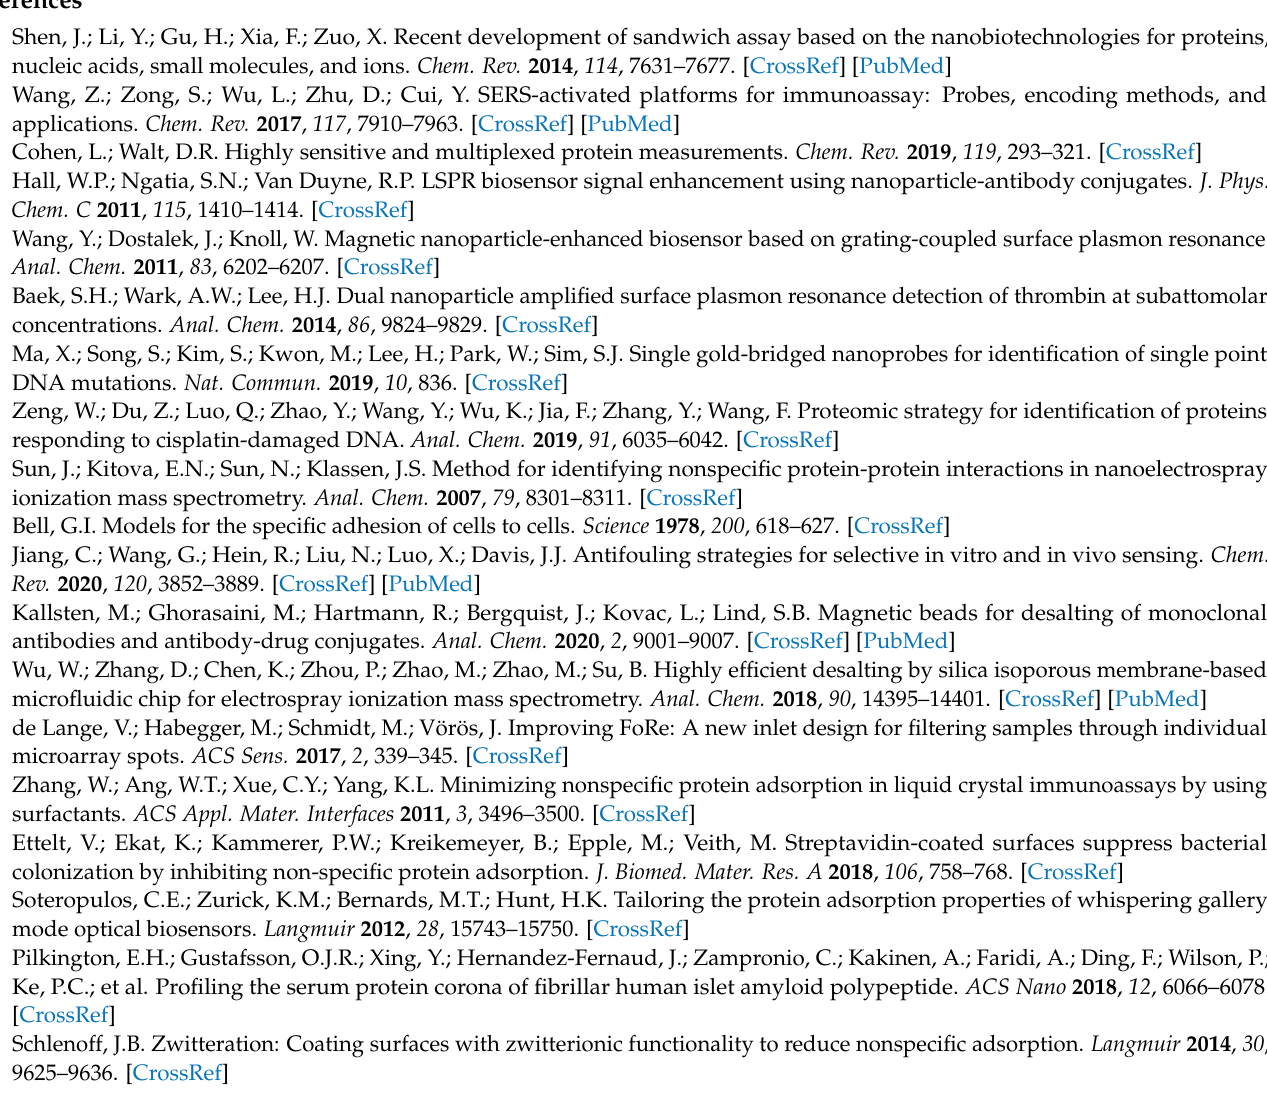
Figure S2: Isothermal titration calorimetry (ITC) analyses of probe-target